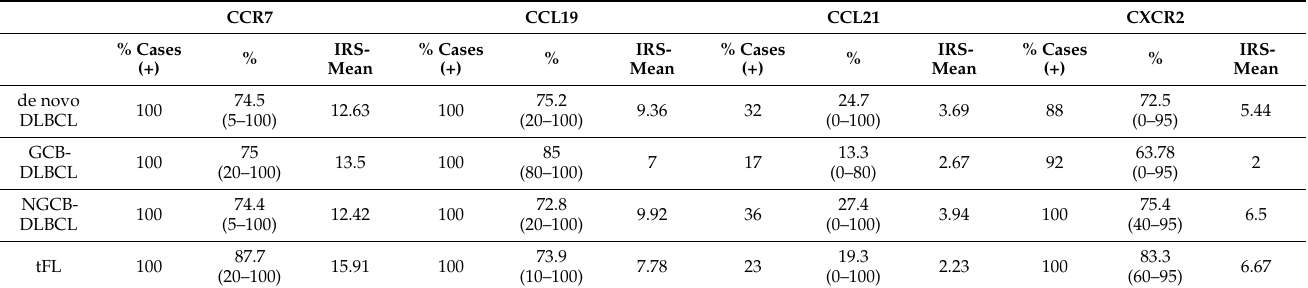
Table 3. Mean percentages and IRS of cells positive for CCR7, CCL19, CCL21, and CXCR2 in de novo DBLCL, GCB-DLBCL, NGCB-DLBCL, and tFL.